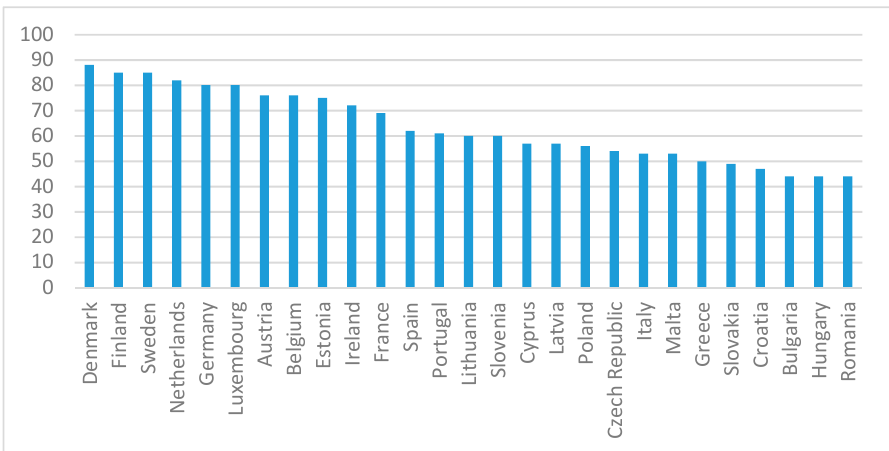
Figure 1. Corruption Perceptions Index scores in European Union countries, 2020. Source: Authors’ procedure based on Corruption Perceptions Index 2020 (https://www.transparency.org, accessed on 1 January 2021).